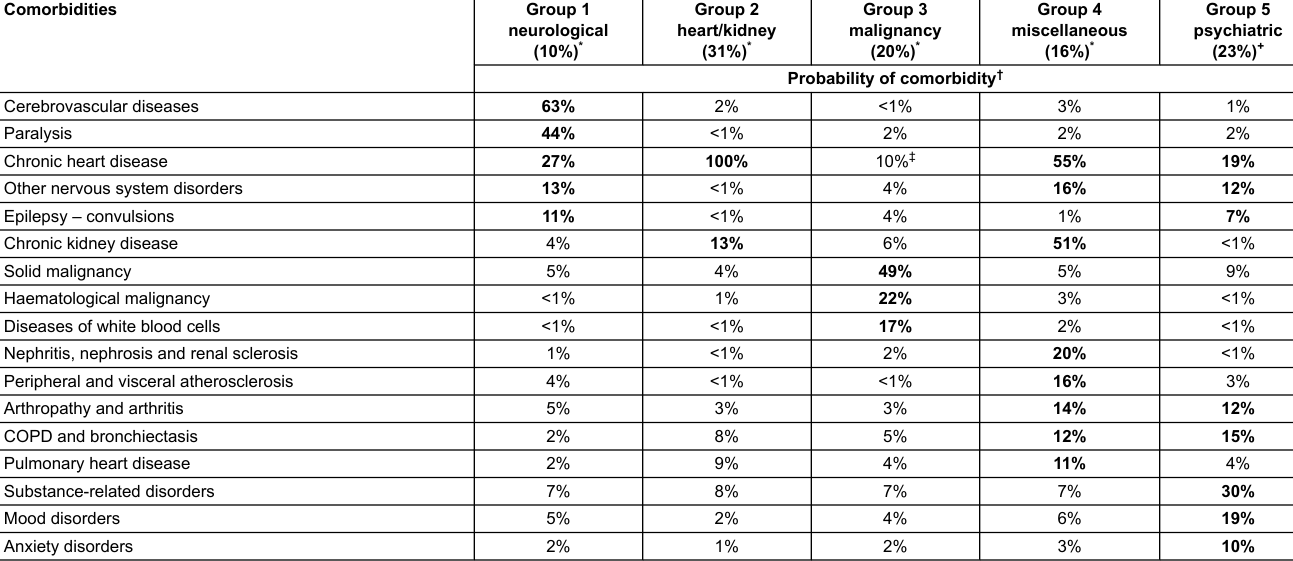
Table 3: Latent class